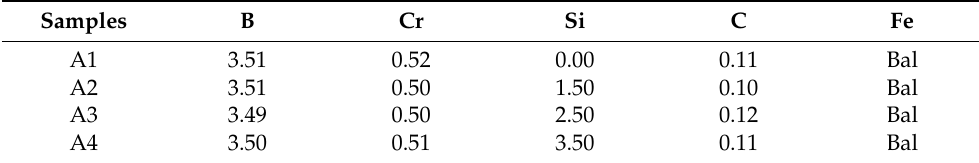
Table 1. Chemical compositions of cast DS Fe-B alloy by spark emission spectrometer (wt.%).